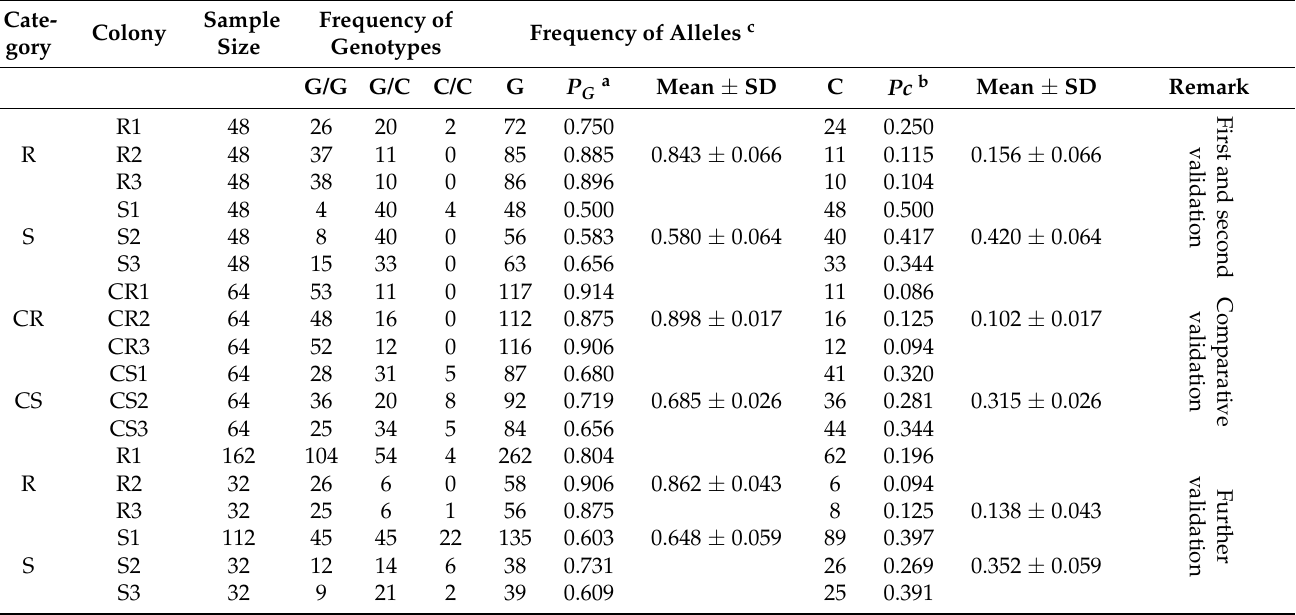
Table 2. Distributions of G and C allele frequencies of SNP